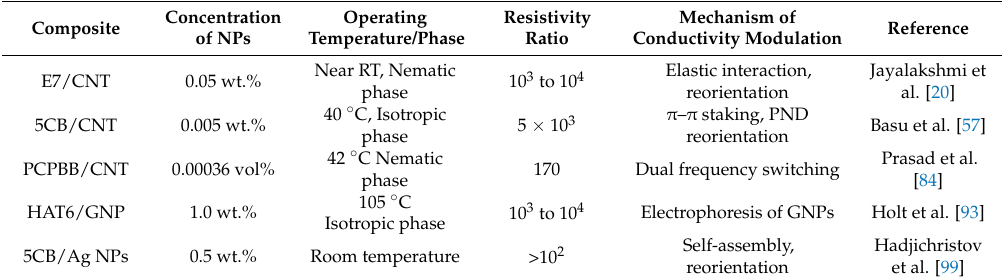
Table 1. A switching performance comparison among various composite